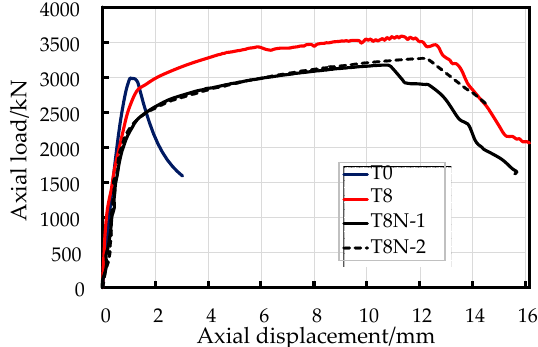
Figure 5. Axial load-displacement curves of specimens.